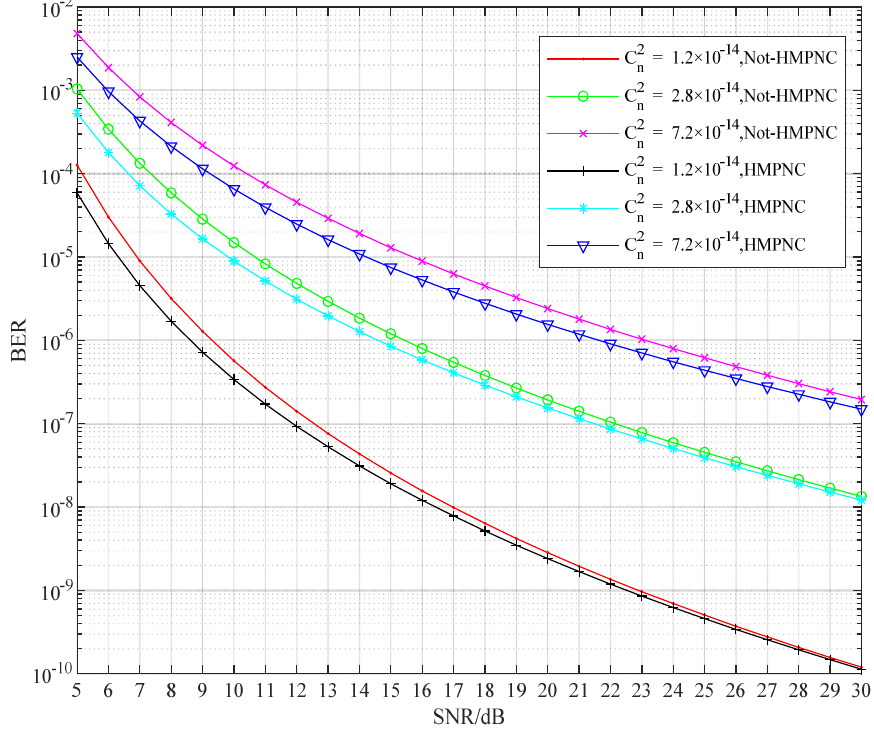
Figure 6. Comparison of the improvement of BER performance of the cooperative FSO communica- tion system by this scheme under different turbulence intensities.